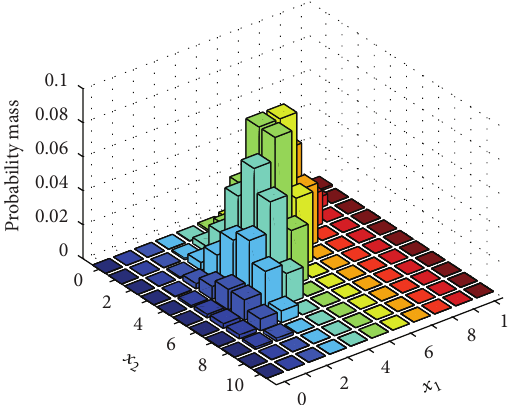
Figure 10: The time and space domain losing packet rate at lower space density.